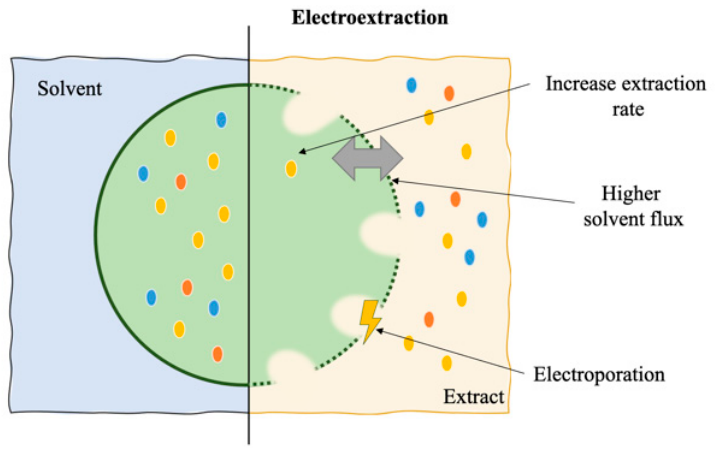
Figure 5. Schematic representation of electroextraction effects in microalgae and cyanobacteria